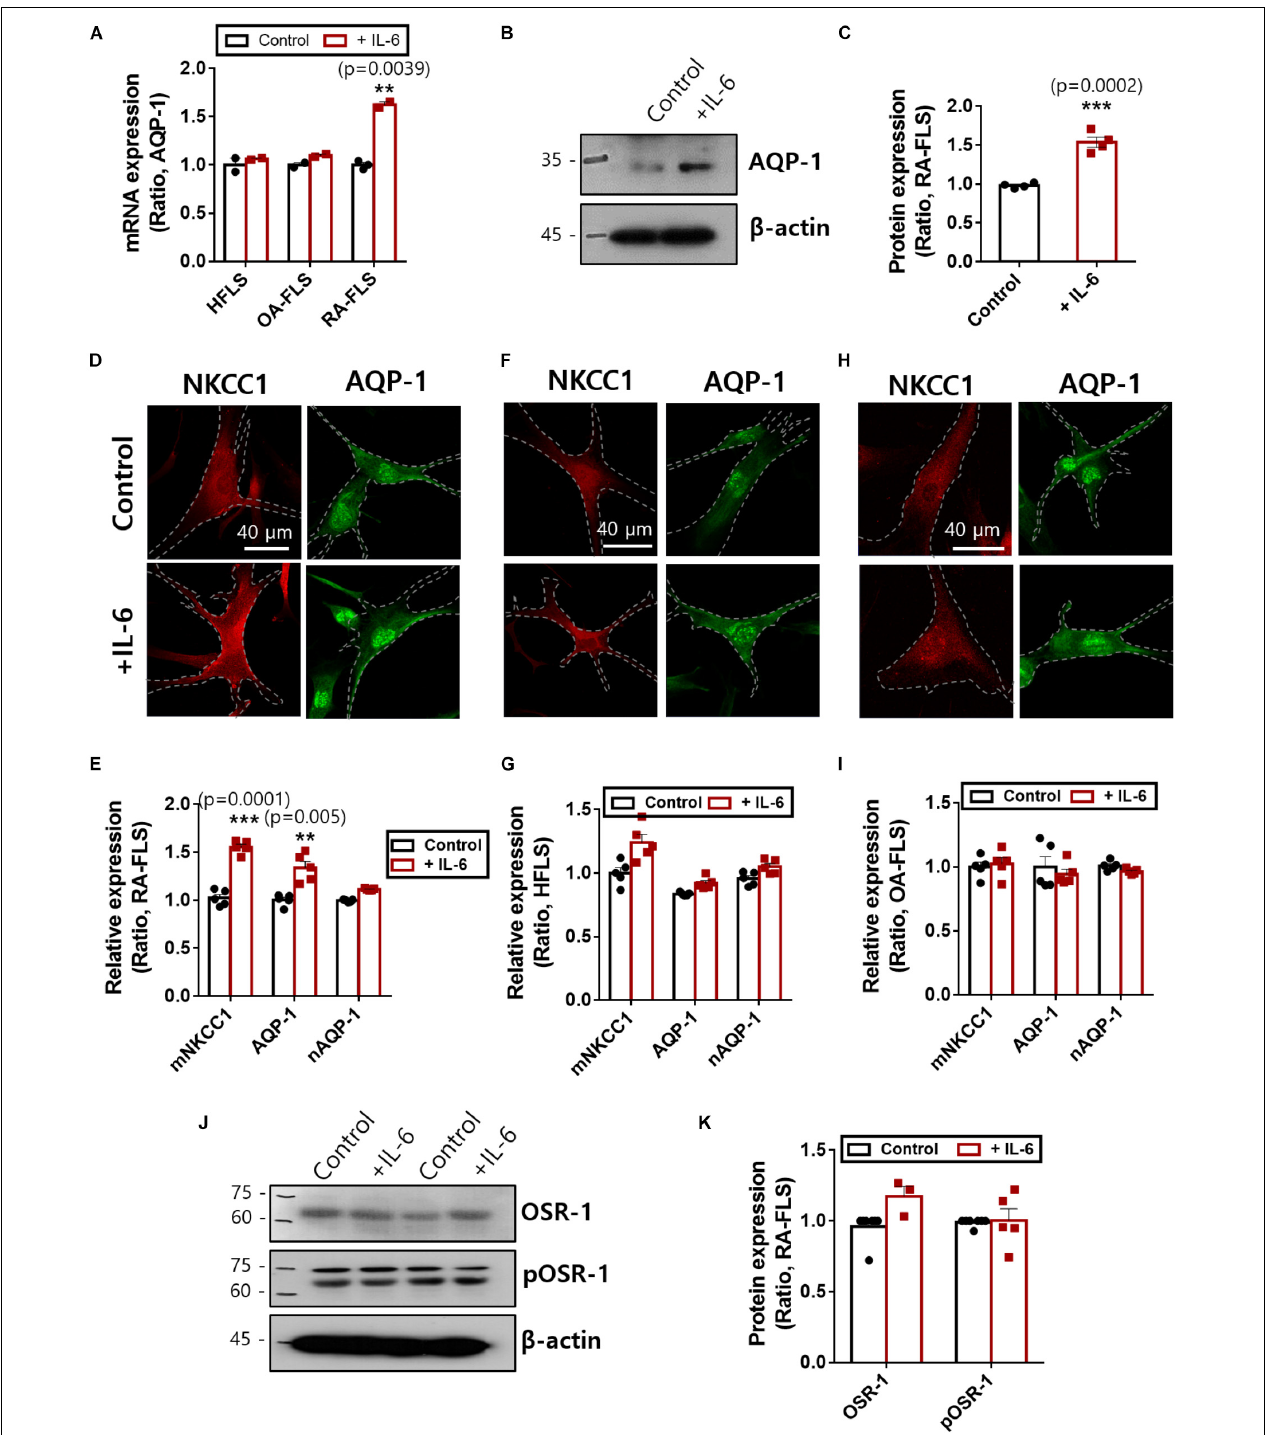
FIGURE 4 | Interleukin (IL)-6 enhanced aquaporin (AQP)-1 expression in rheumatoid arthritis fibroblast-like synoviocytes (RA-FLS). (A) mRNA levels [ n = 3, ** p < 0.01, *: Control vs + (IL) − 6] and (B) protein levels of AQP-1 with pretreatment of 50 ng/ml IL-6 for 48 h in human FLS (HFLS), osteoarthritis FLS (OA-FLS), and RA-FLS. β -Actin was used as a loading control. (C) Analysis of band intensity of AQP-1 protein levels in RA-FLS [ n = 4, *** p < 0.001, *: Control vs + (IL) − 6]. Immunolocalization of NKCC1 (red) and AQP-1 (green) with treatment of 50 ng/ml IL-6 in (D) RA-FLS, (F) HFLS, and (H) OA-FLS. Analysis of membranous intensity of sodium–potassium–chloride cotransporter1 (NKCC1) and AQP-1 and nuclear staining of AQP-1 in (E) RA-FLS [ n = 5, ** p < 0.01 and *** p < 0.001, *: Control vs + (IL) − 6], (G) HFLS, and (I) OA-FLS. (J) Protein levels of OSR-1 and pOSR-1 with treatment of 50 ng/ml IL-6 for 48 h of RA-FLS. β -Actin was used as a loading control. (K) Analysis of band intensity of OSR-1 and pOSR-1 in RA-FLS.